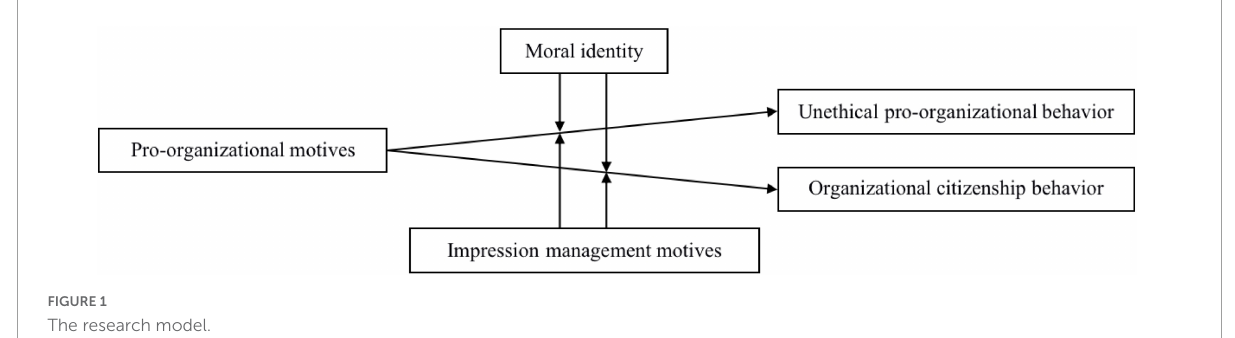
FIGURE1 The research